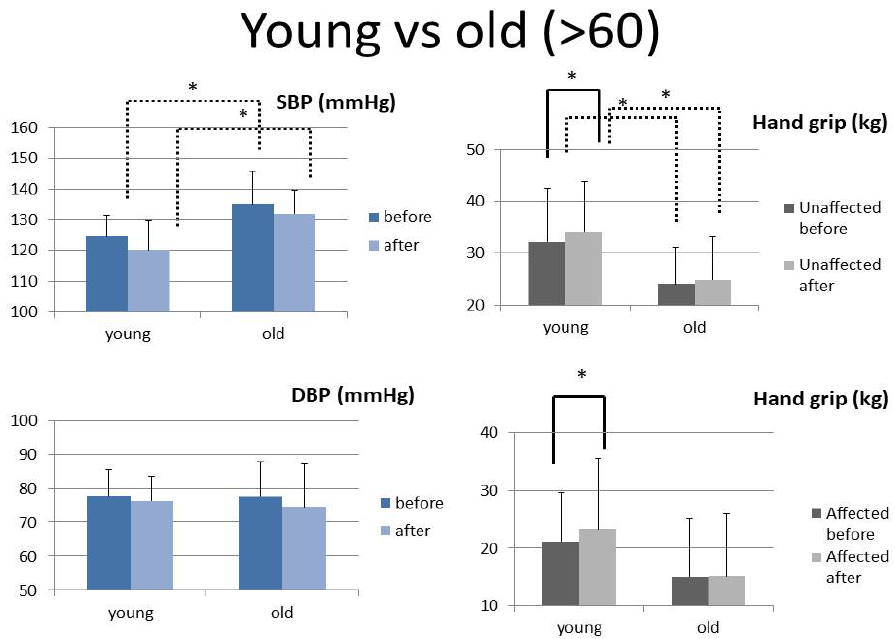
Figure 4. The pre- and post-intervention levels of SBP, DBP, and handgrip of the unaffected and affected hands between the young and old groups (paired t -test is shown with a solid line and independent t -test with a dotted line) *: p < 0.05. (Bars represent the standard